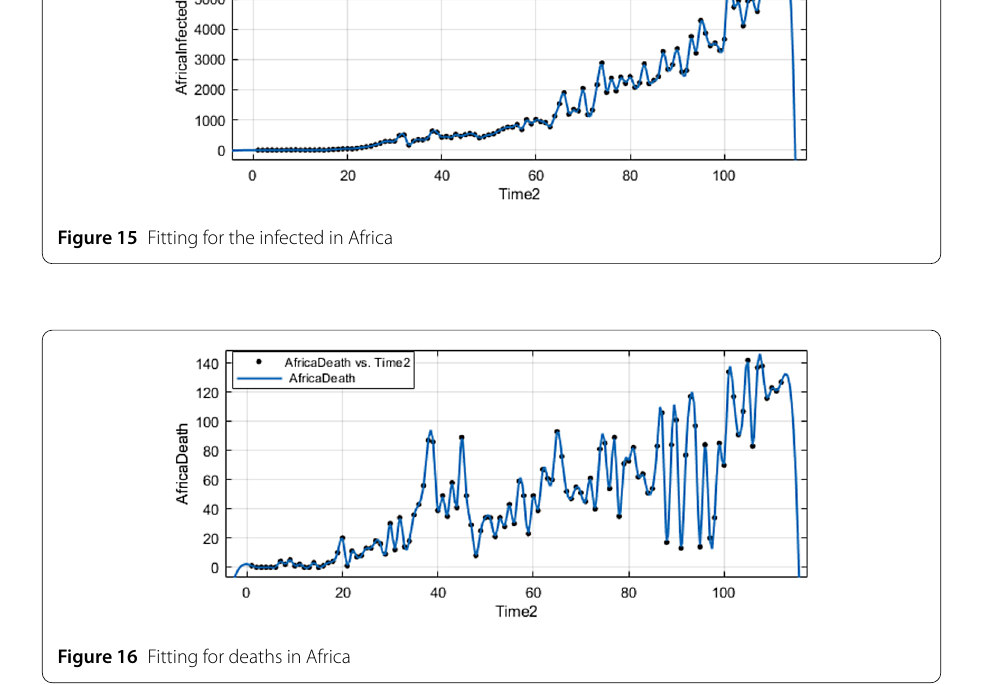
Figure 16 Fitting for deaths in Africa